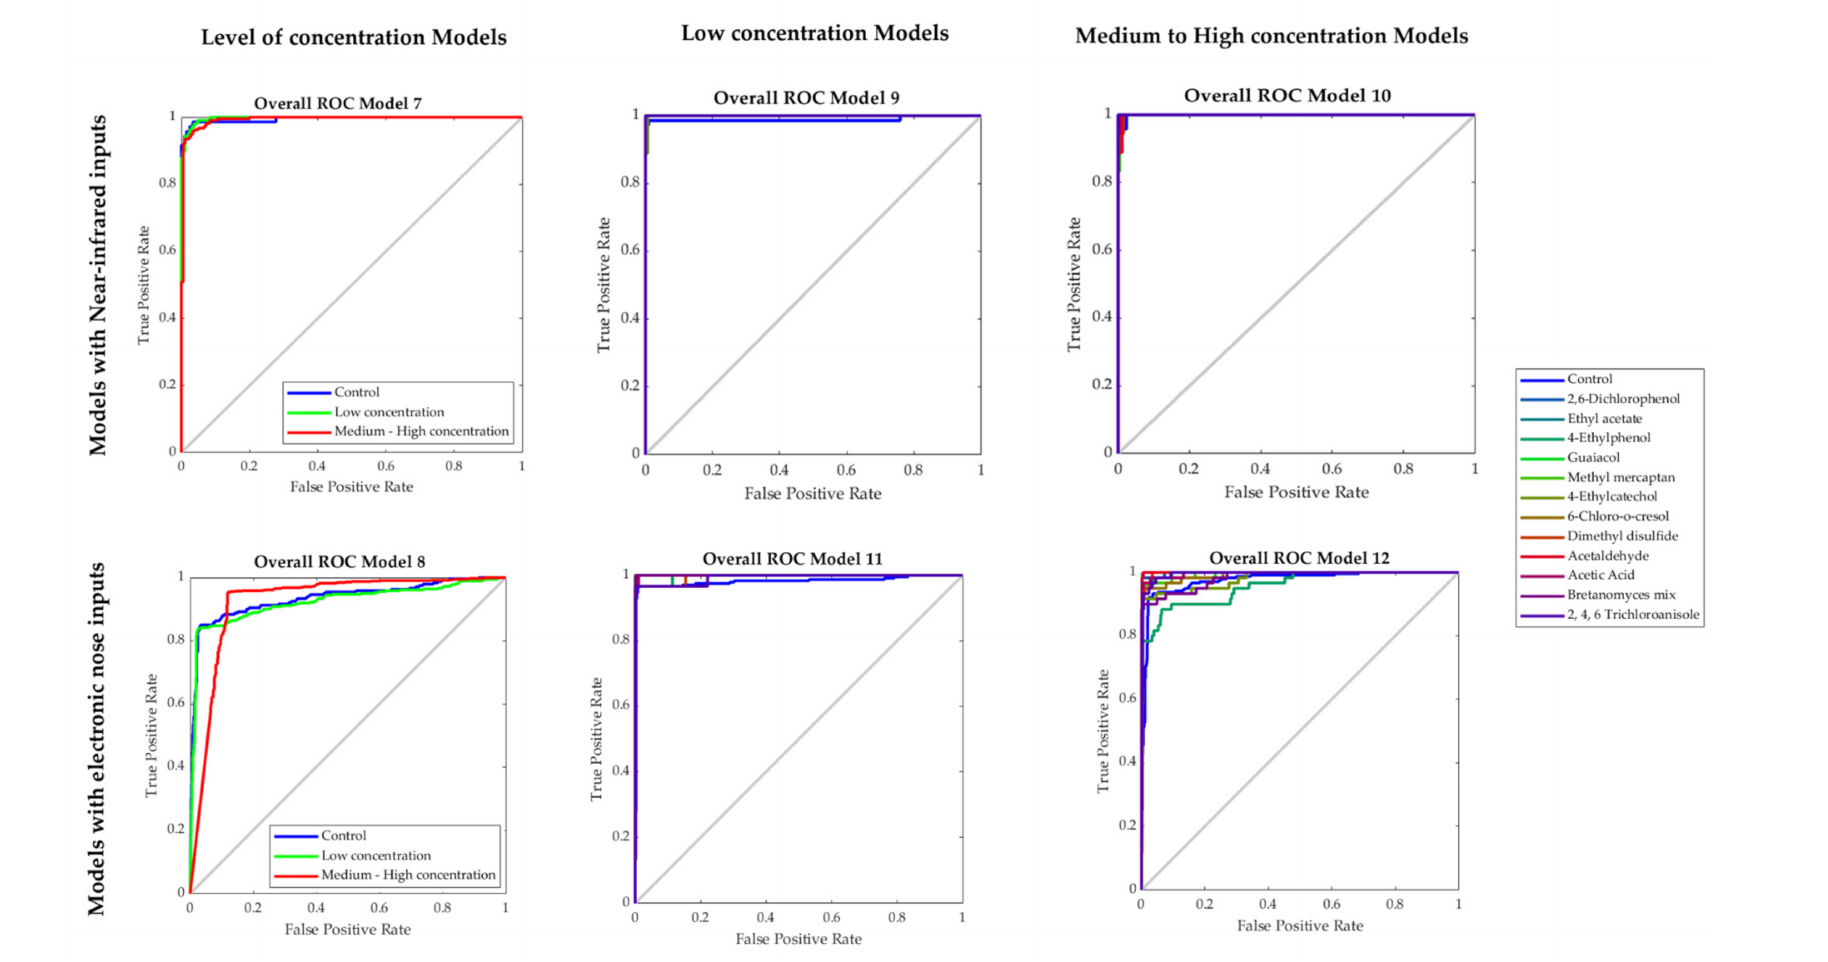
Figure 6. Receiver operating characteristics (ROC) curves of the overall Models 7–12 developed for white